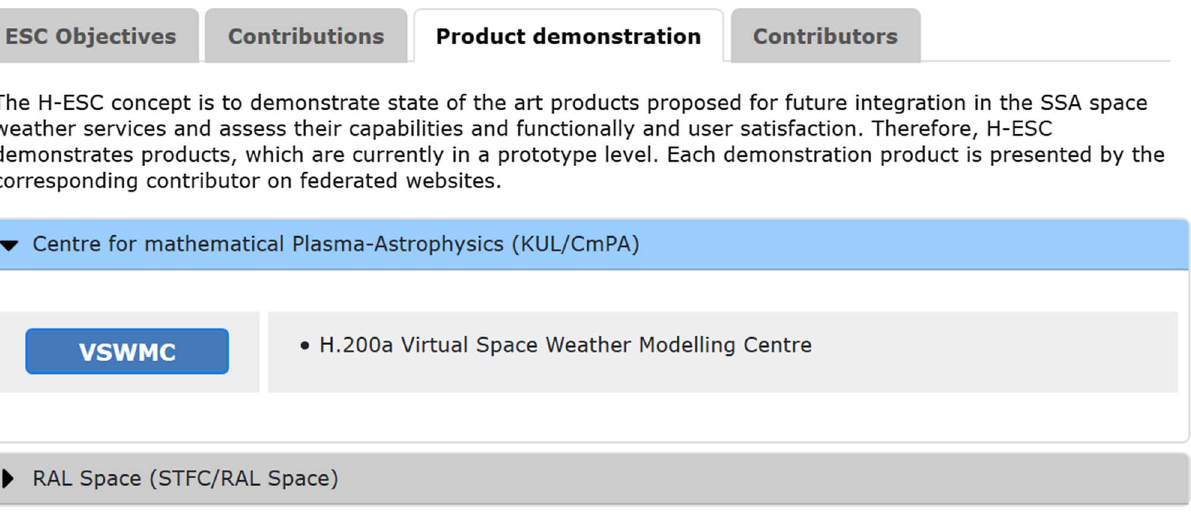
Fig. 5. Screen shot of the H-ESC webpage with the Link “ VSWMC ” on the “ Product demonstration ” tab that gives access to the login page of the